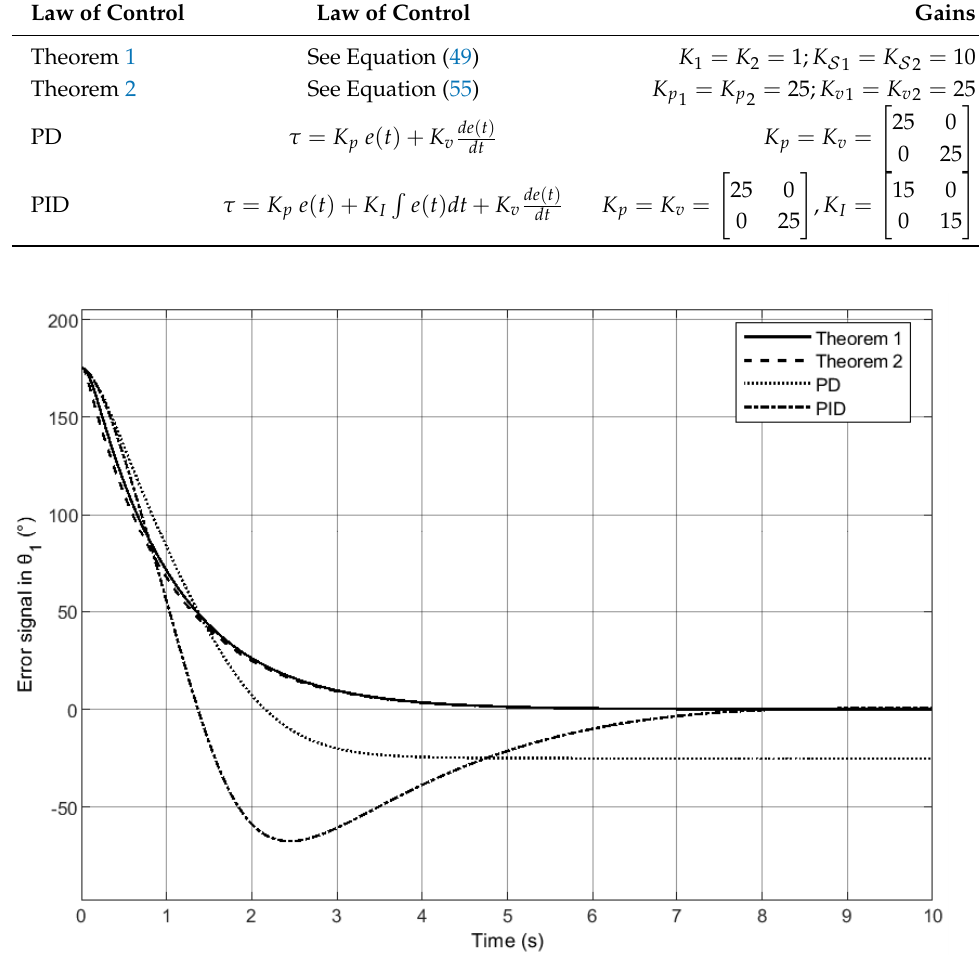
Table 4. Feedback controllers.